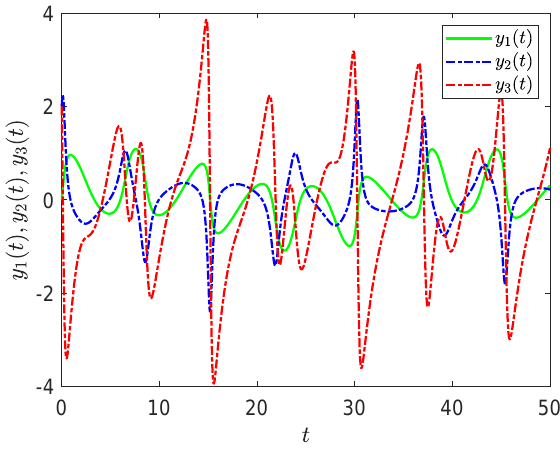
Figure 33. Solution profiles of the chaotic system.